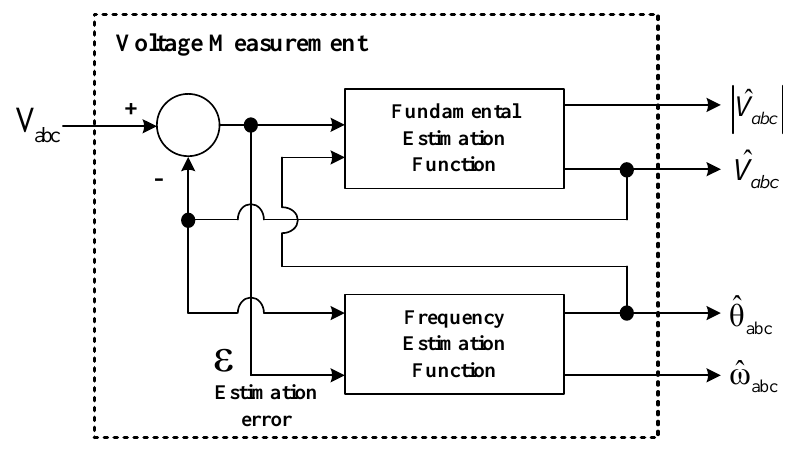
Figure 5. Block diagram of the proposed voltage measurement